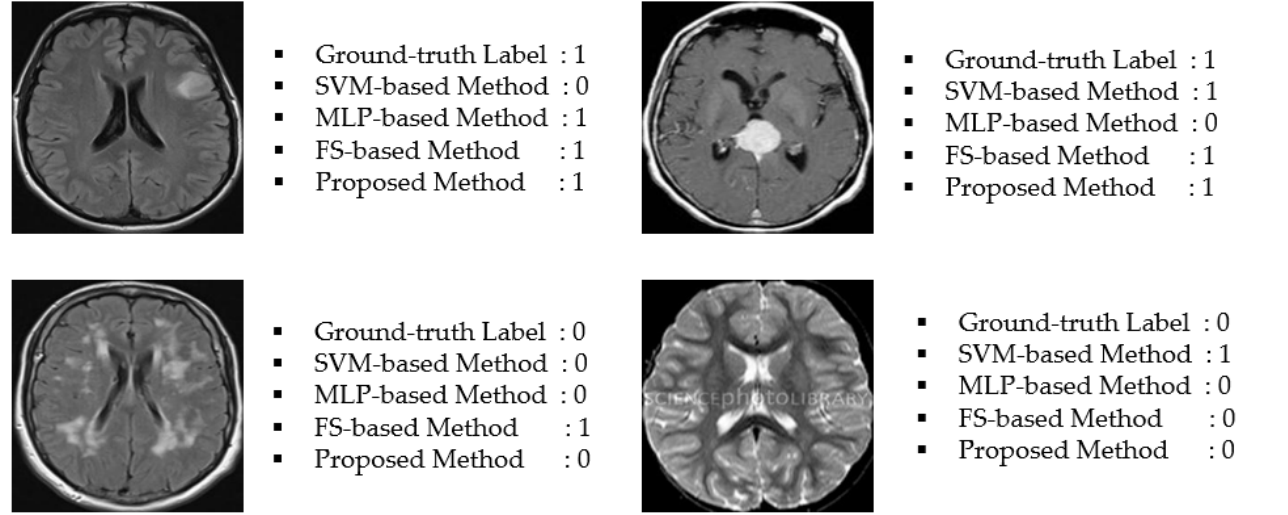
Figure 11. Examples of error cases of single classification methods: ( a ) SVM-based method, ( b ) MLP-based method, and ( c ) FS-based method. (Left pair: Non-tumor to tumor cases; Right pair: Tumor to non-tumor cases).